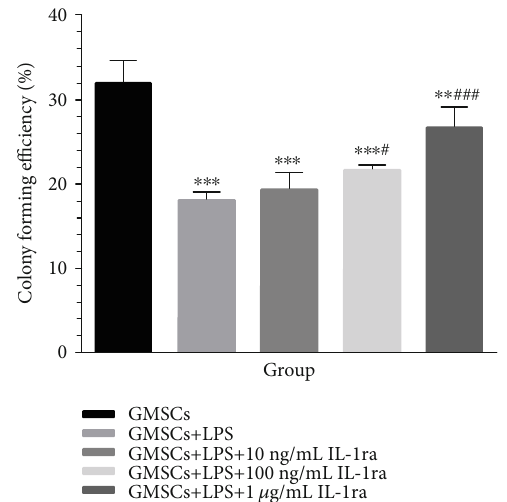
Figure 4: E ff ect of P. gingivalis -LPS and IL-1ra on rGMSC colony formation e ffi ciency at 14 days. ∗∗ P < 0 : 01 , ∗∗∗ P < 0 : 001 vs. GMSCs; # P < 0 : 05 , ### P < 0 : 001 vs. GMSCs+LPS.